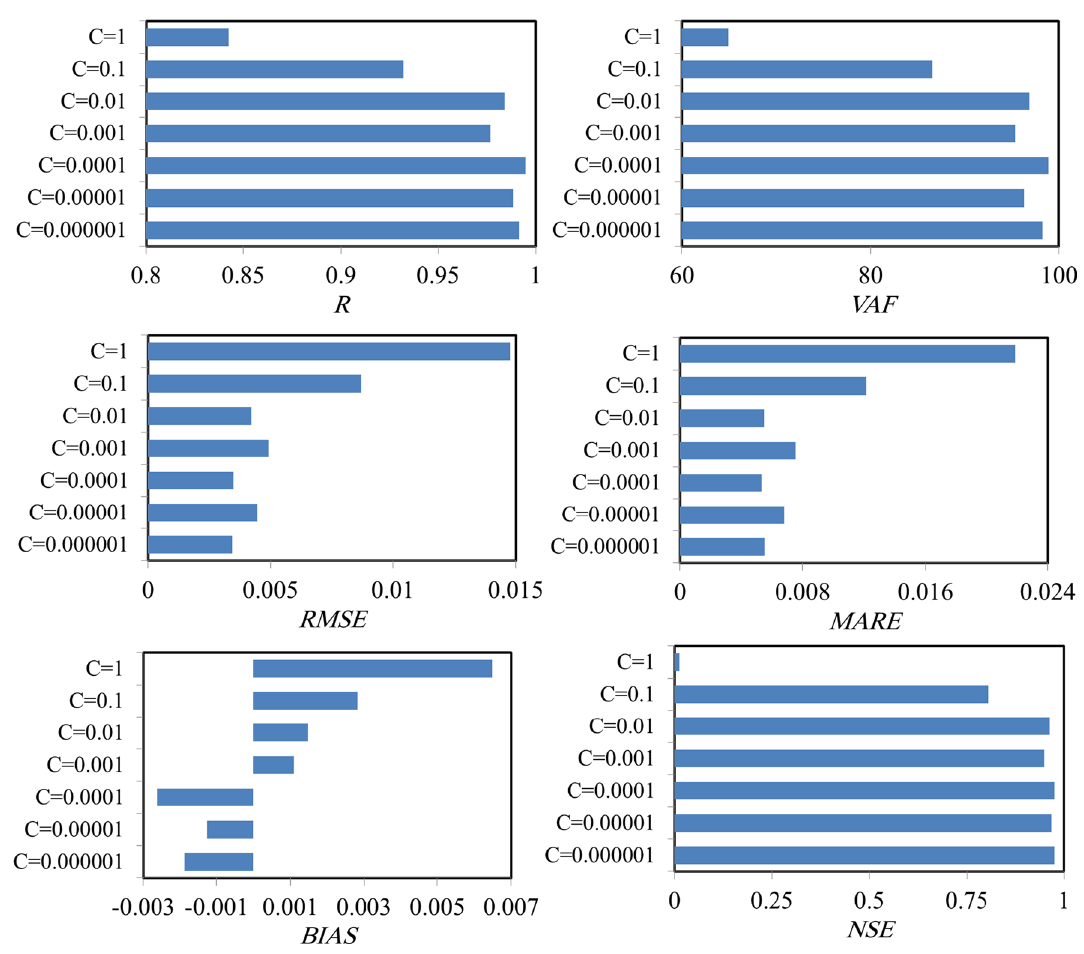
Fig. 9 Different statistical indices estimated for different regularization parameters